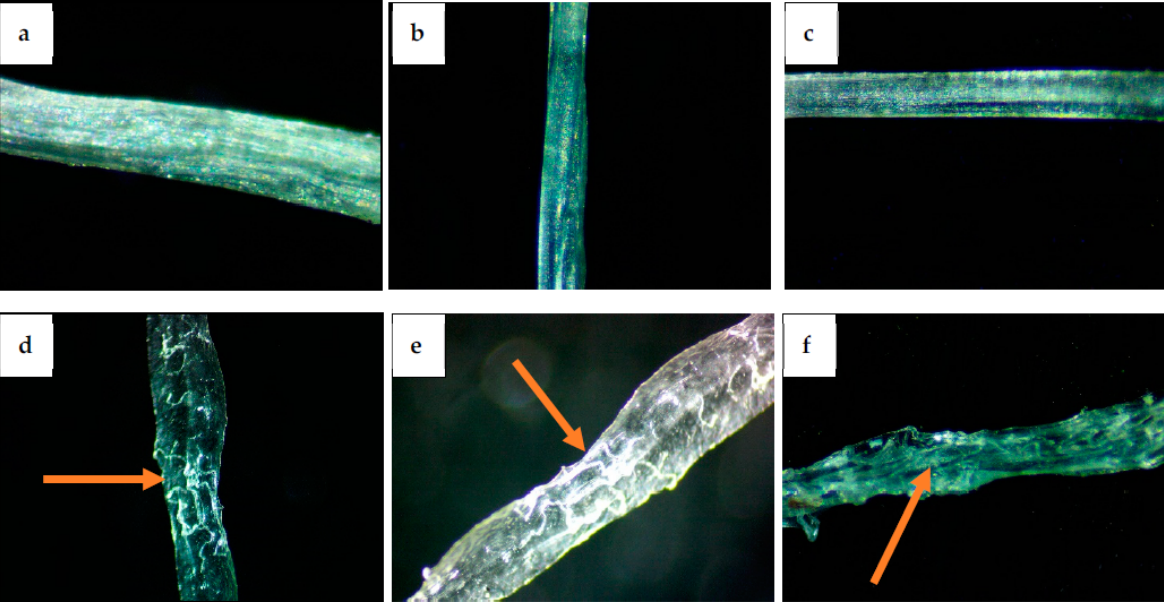
Figure 3. Microscopic images of Pure alginate Hydrogel fibers (( a ): 1%, ( b ): 1.25%, ( c ): 1.5%) and cotton reinforced alginate hydrogel fibers (( d ): 1%, ( e ): 1.25%, ( f ): 1.5%).